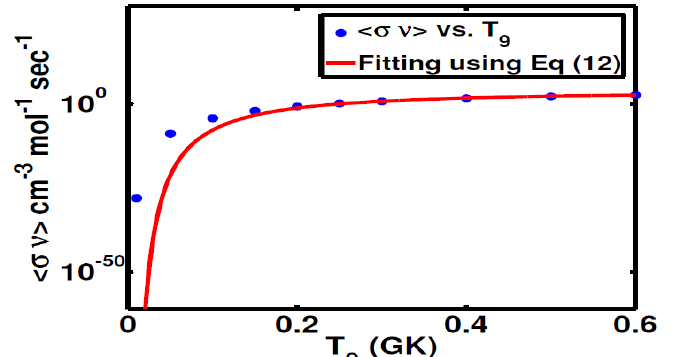
Figure 4: The results of fitting procedure for theoretical reaction rates of nuclear reaction using Eq. (10). The fitting parameters were a = 4.169 , and b = 3.202, and the goodness was